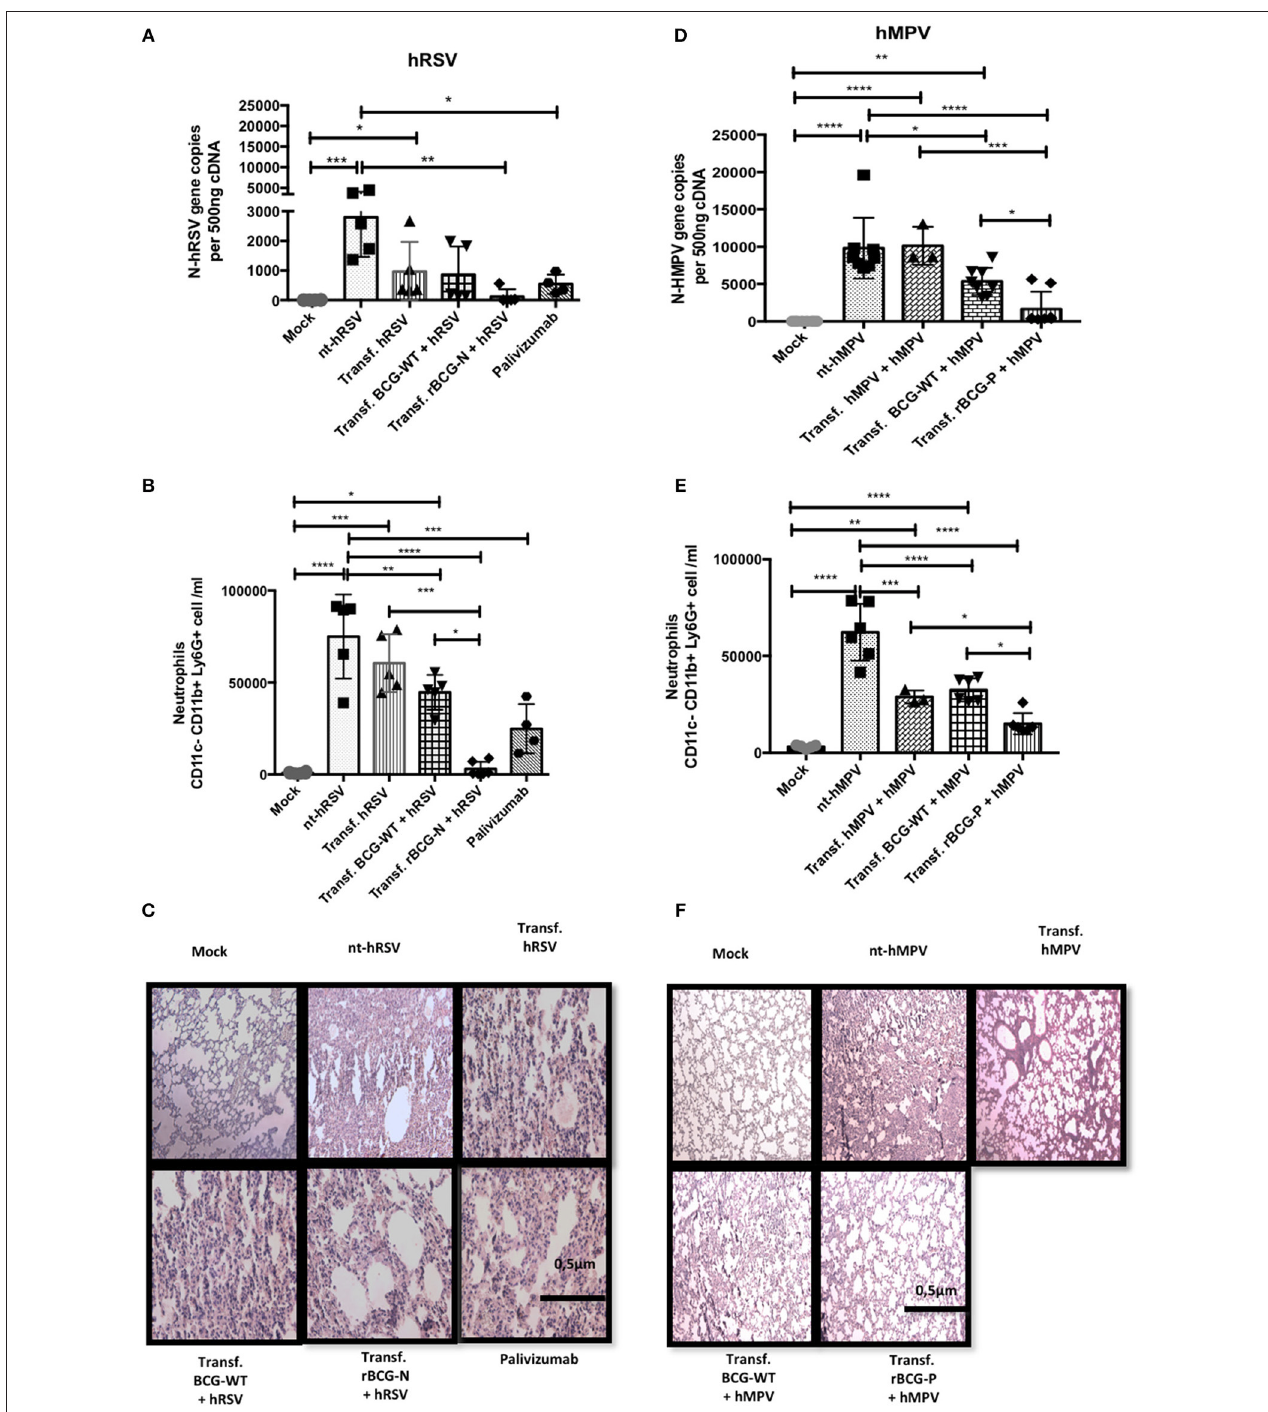
FIGURE 6 | Passive immunity transfer from sera of previously rBCG immunized mice protects naïve mice from hRSV- and hMPV-associated pathology. Sera from 14 dpi (hRSV) or 49 dpi (hMPV) was passively transferred to naïve mice. Then mice were then infected with hRSV or hMPV, respectively. As a control, a non-transferred group was also infected (nt-hRSV or nt-hMPV). Parameters as viral load in lung by RT-qPCR (A for hRSV and D for hMPV), neutrophils infiltrated in BALs (B for hRSV and E for hMPV) and histopathological lung H&E staining (C for hRSV and F for hMPV) were evaluated. For hRSV, Palivizumab was used as a positive control. The bars observed in the (B,C) are accordingly: Mock-treated, nt-hRSV, Transf. hRSV, Transf. BCG-WT + hRSV, and Transf. rBCG-N + hRSV and Palivizumab. On the other hand, the bars observed in (E,F) are accordingly: Mock-treated, nt-hMPV, Transf. hMPV Transf. BCG-WT + hMPV, and Transf. rBCG-P + hMPV. Differences were evaluated by a one-way ANOVA (* p ≤ 0.05; ** p ≤ 0.01; *** p ≤ 0.001; **** p ≤ 0.0001). These results are from two independent experiments with 3 animals by group. The error bars represent the Standard Deviation